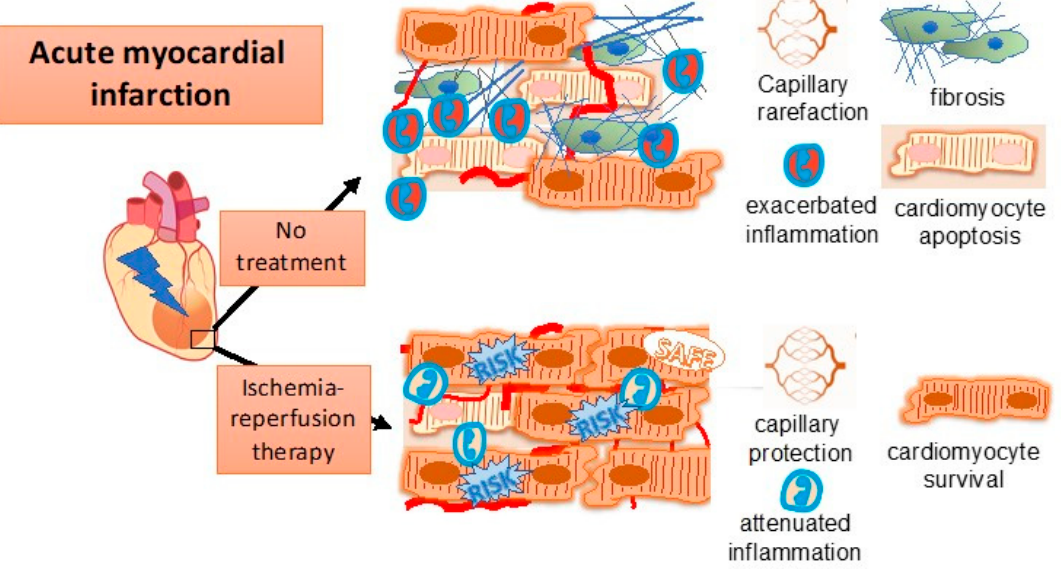
Figure 1. Key players in ischemia reperfusion injury are inflammation, endothelial dysfunction and cardiomyocyte